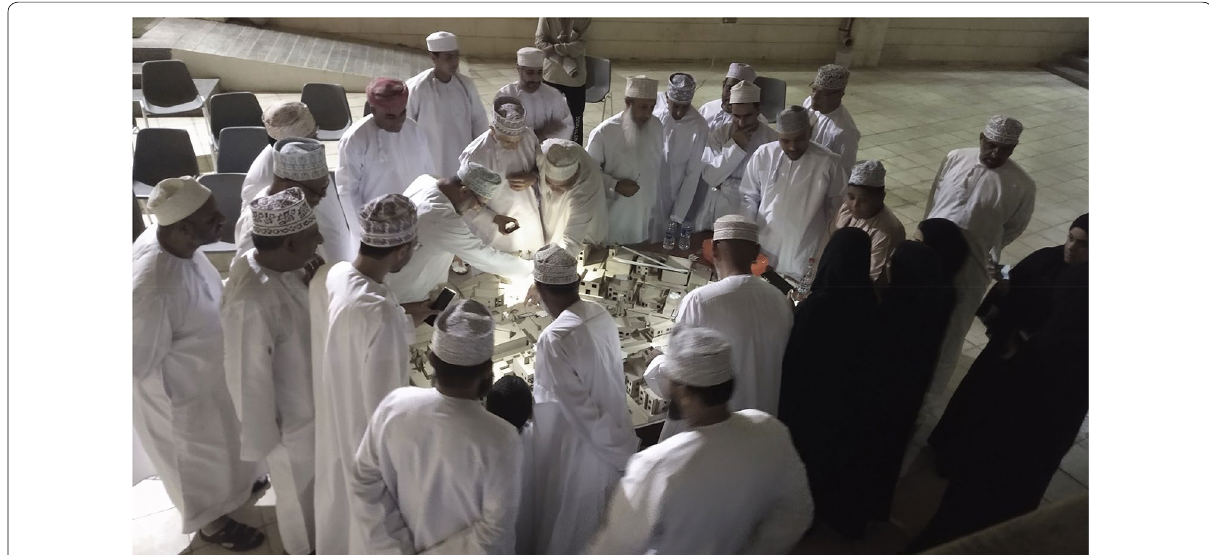
Fig. 6 Male workshop in the neighborhood of Al Ansab led by GUTech female students in 2019 within the boundary walls of the Ansar Heights Mosque—residents and the Imam discussing a paved alleyway and open spaces beside the mosque that is considered ‘dangerous’ as cars pass at high speed. Picture by the paper’s